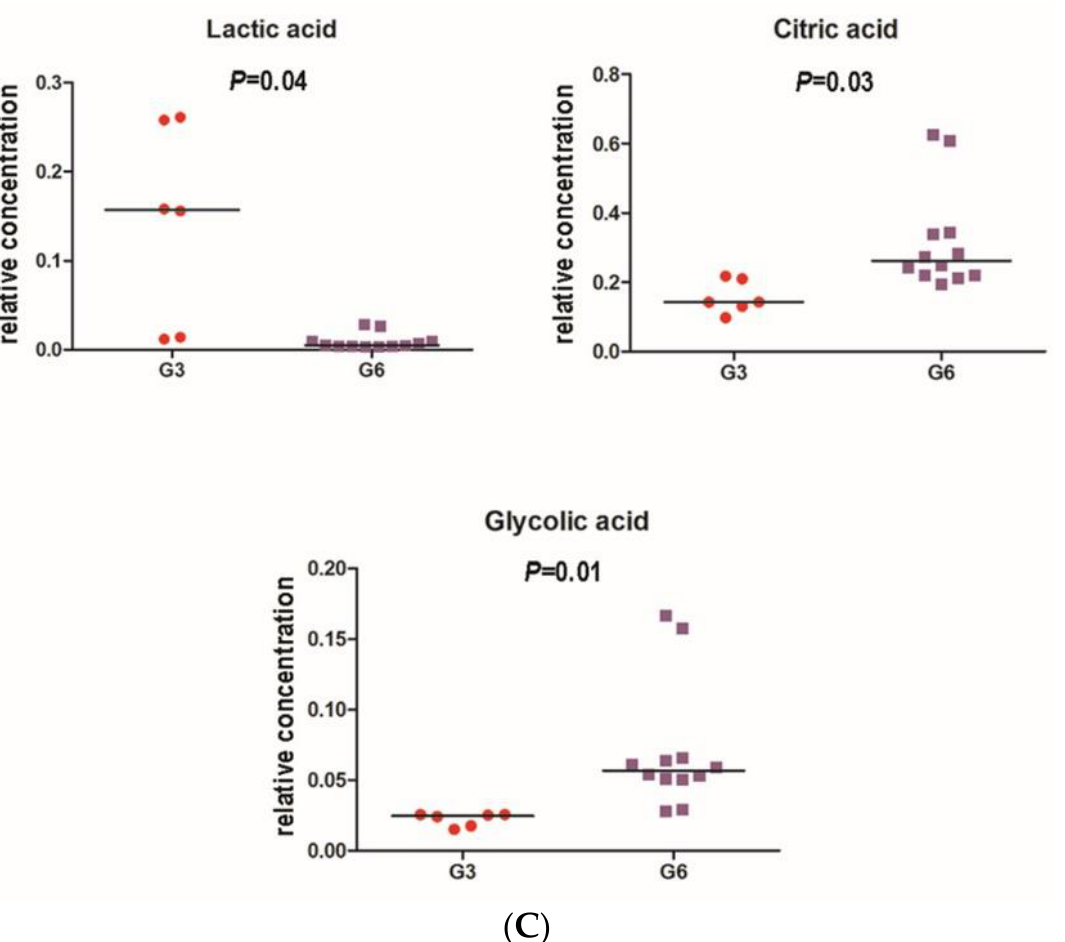
Figure 5. ( A ), Univariate analysis (Mann–Whitney) for a grape diet (Day 30) compared to restricted diet (Day 15) for UV-resistant subjects (M1; n = 9; red) and non-resistant (M2; n = 20; green) subjects. Data presented as duplicate analyses; p -values are Bonferroni corrected for four comparisons. All three urinary metabolites shown were depressed in the UV-resistant group. ( B ), Univariate analysis (Mann–Whitney) for urinary metabolites after grape diet (Day 30; blue) compared to restricted diet (Day 15; green) for UV-resistant subjects ( n = 9). Data presented as duplicate analyses; p -values are Bonferroni corrected for 14 comparisons and remain barely statistically significant. All three urinary metabolites shown were depressed by grape diet. ( C ), Univariate analysis (Mann–Whitney) for urinary metabolites after the final washout period (Day 60) showing separation of subgroup G3 ( n = 3; red) vs. subgroup G6 ( n = 6; purple). G3 showed UV resistance on Day 30 and Day 60; G6 showed UV resistance on Day 30 but not Day 60. Data presented as duplicate analyses; p -values are Bonfer- roni corrected for 4 comparisons.